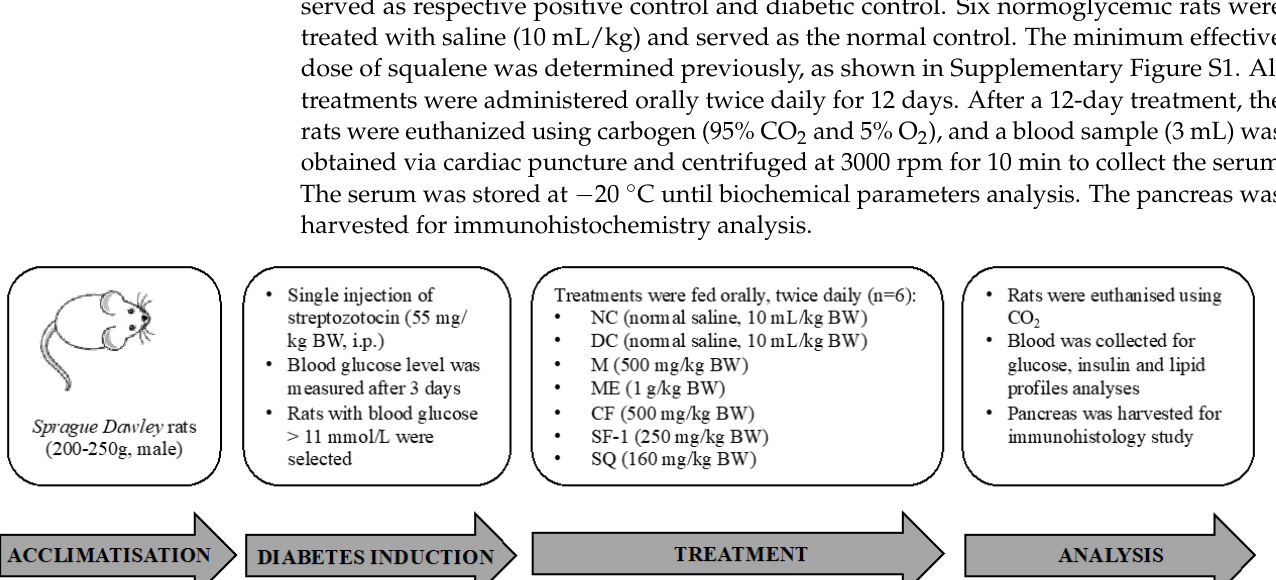
Figure 10. In vivo antihyperglycemic